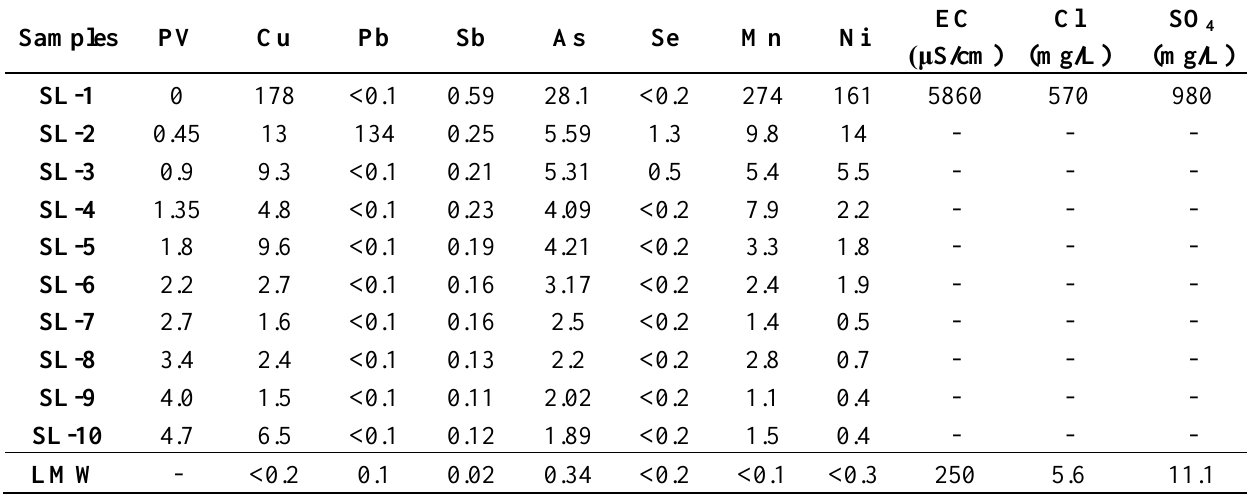
Table 3. Chemical composition of fluids from column leaching experiment with biosolid. Values in